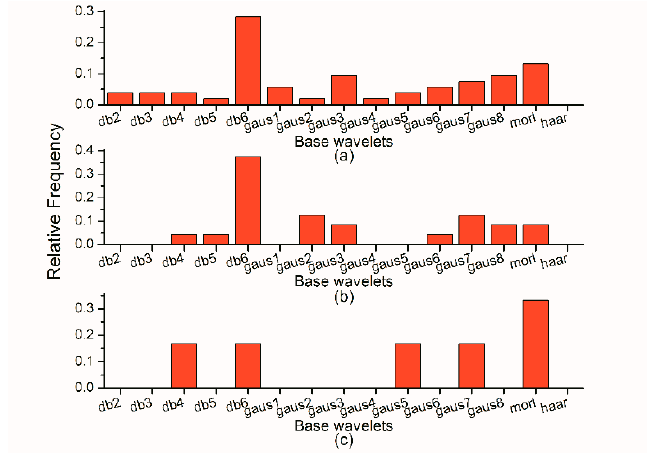
Figure 15. The relative frequency distribution for the occurrence of the mother wavelets in the 53 sets qualified earthquake motions ( a ) Wn 1 , ( b ) Wn 2 , and ( c ) Wn 3 .